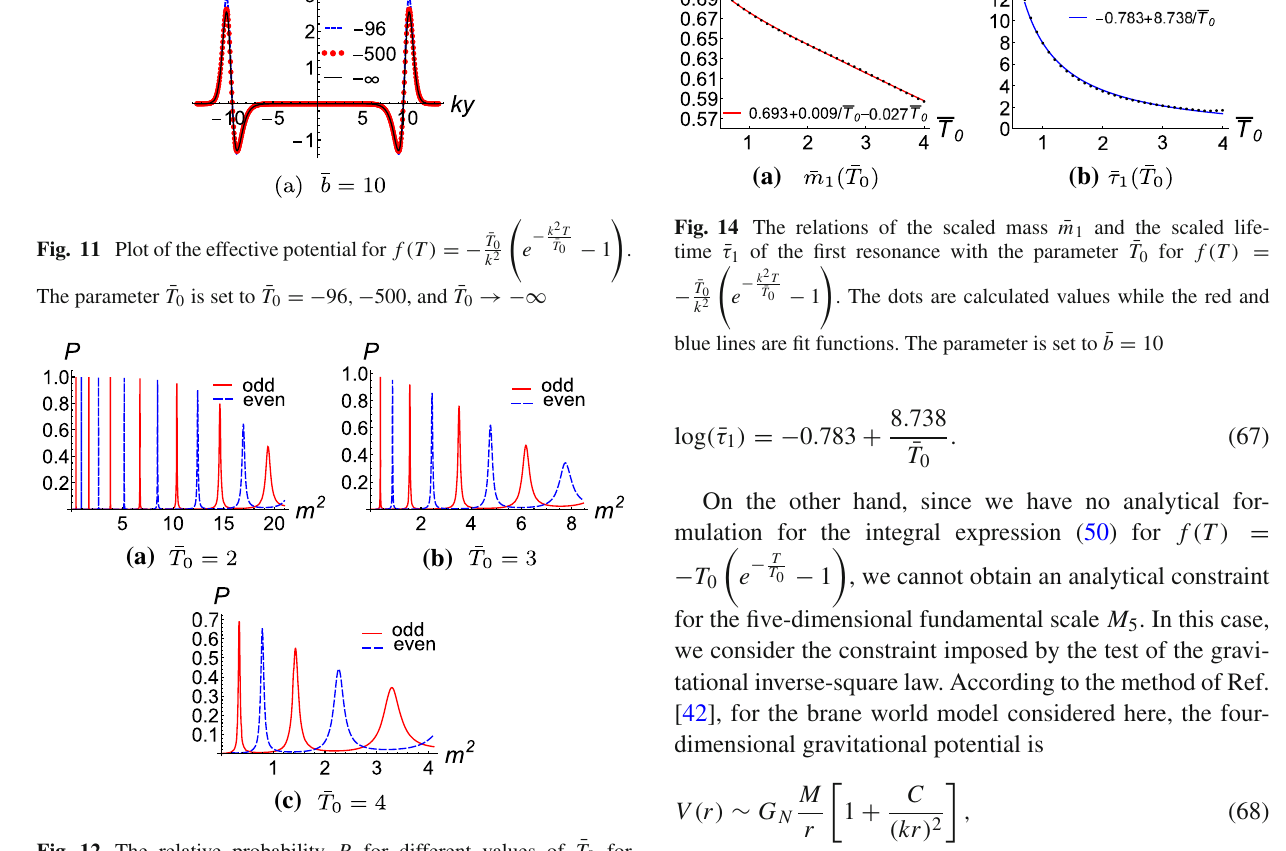
Fig. 12 The relative probability P for different values of ¯ T 0 for (cid:15) ¯ T f ( T ) = − 0 . The red and dashed blue lines correspond k 2 to odd and even parities, respectively. The parameter is set to ¯ b = 10